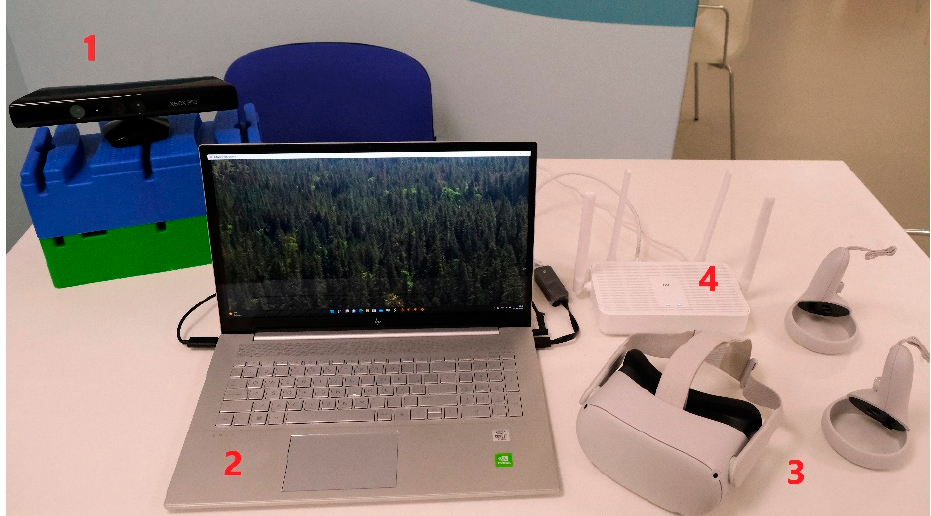
Figure 2. VR equipment used. 1. Kinect 360 2. Computer with the software. 3. VR glasses (oculus Quest 2) 4.